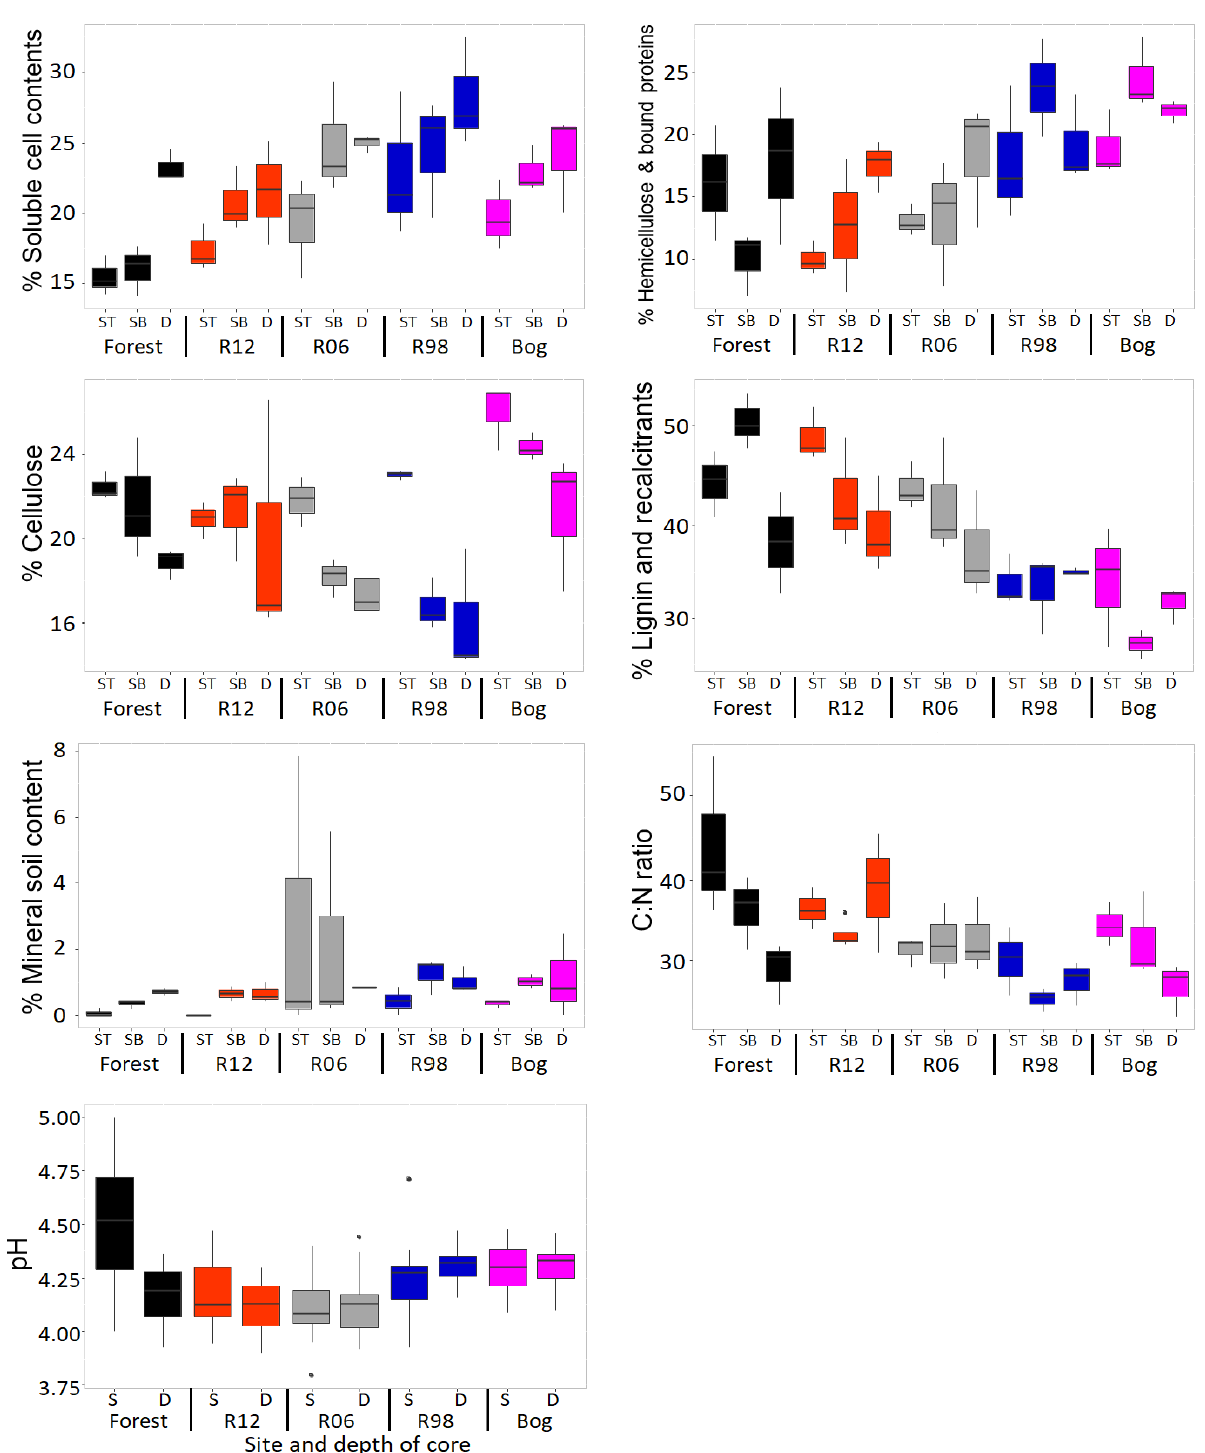
Figure 5. Peat quality per site divided by core depth; Deep (D), and shallow cores separated into top (ST) and bottom (SB) sections. Hinges correspond to the first and third quartiles and whiskers to 1.5 * inter- quartile range. See text for statistical indicators. With A) Percentage soluble components, B) Percentage hemicellulose, C) Percentage cellulose, D) Percentage lignin and recalcitrant materials, E) Percentage mineral soil, F) C:N ratio of the soil and G) soil